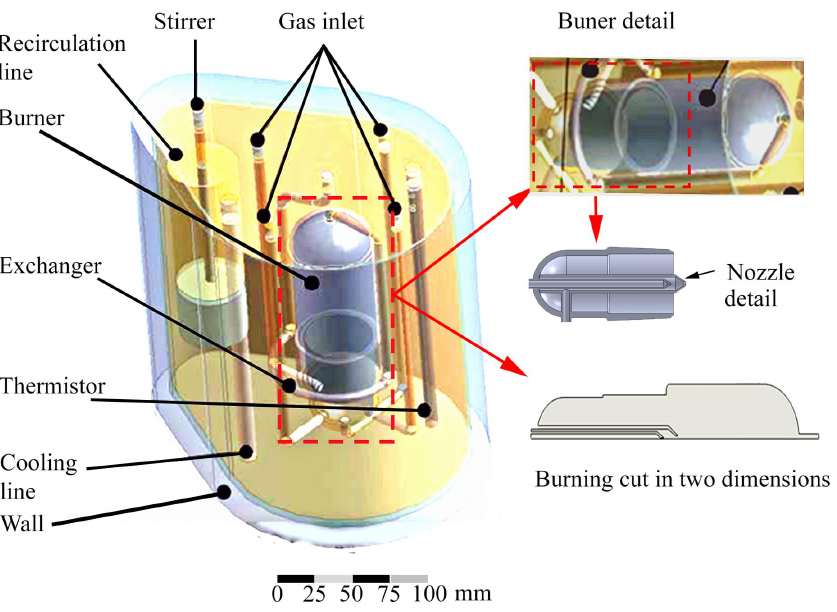
Figure 1. Schematic diagram of a reference calorimeter from [9] with details about the nozzle and 2D geometry used in the